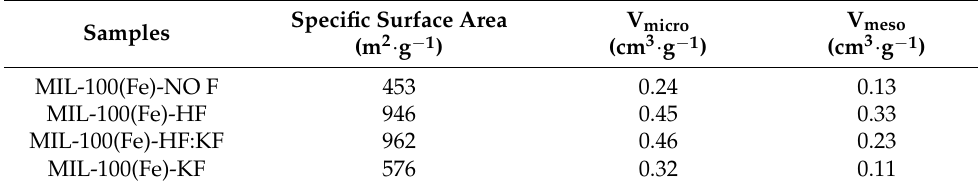
Figure 2. N 2 adsorption–desorption isotherms of MIL-100(Fe) synthesized. Table 1. Values of specific surface area, micropore volume, and mesopore volume for the synthesized MIL-100(Fe), determined from N 2 sorption measurements.